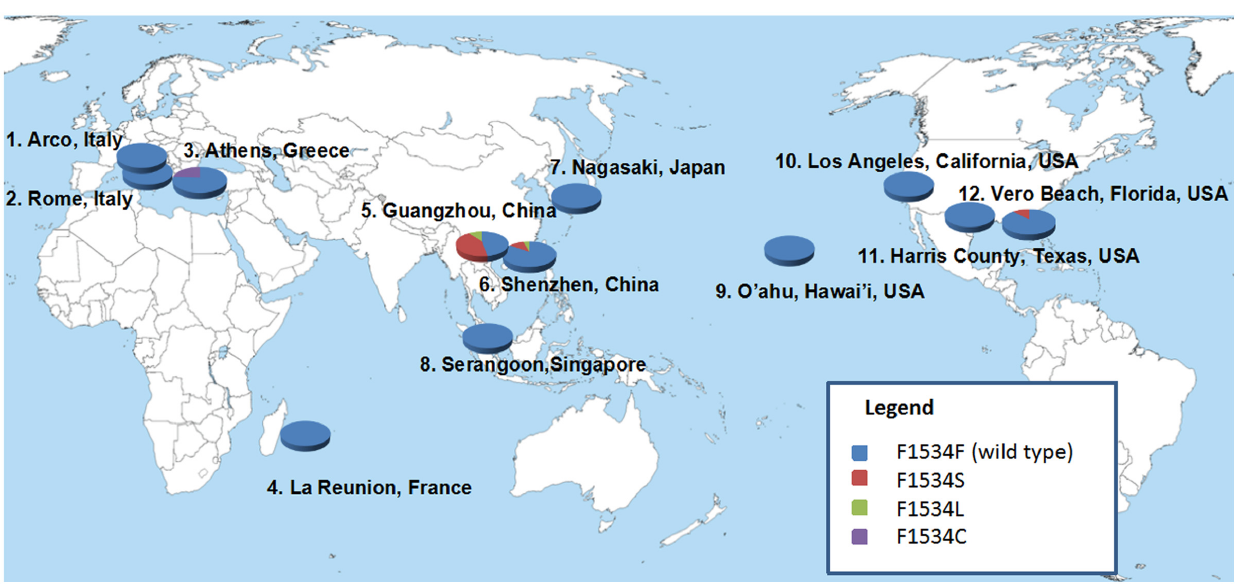
Fig 1. Distribution of mutation frequencies of Voltage-gated Sodium Channel gene at F1534 locus in 12 field Aedes albopictus populations.